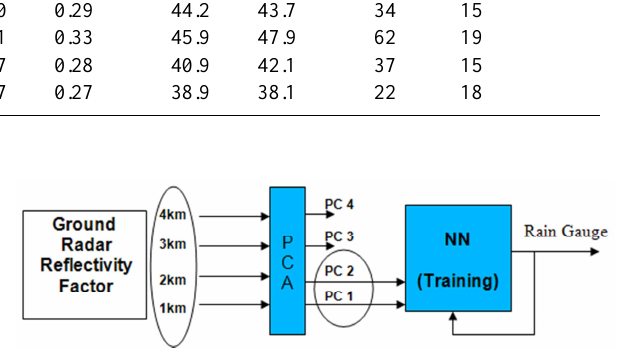
Radar Radar data data